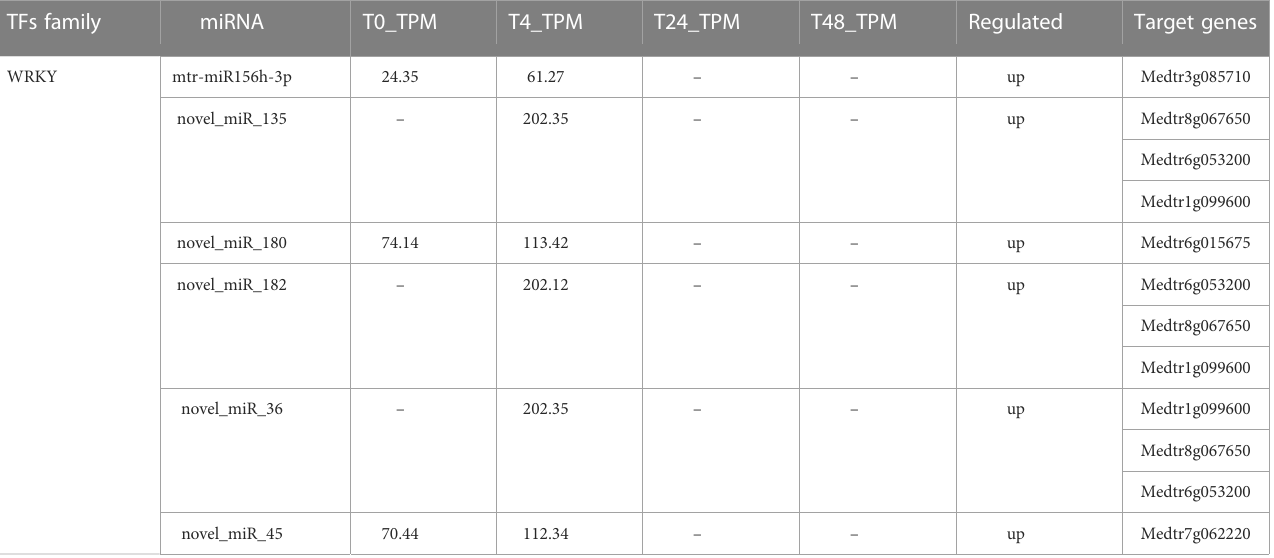
TABLE 1B Information About Special MiRNA. TFs